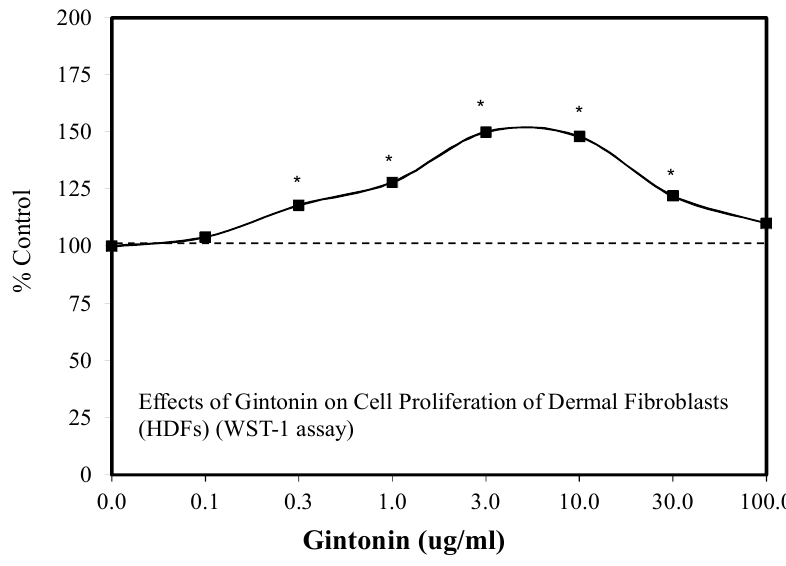
Figure 42. Effects of gintonin on cell proliferation of dermal fibroblasts (HDFs) (WST-1 assay) (source: [123]). Each * represent statistical significance for a data point.